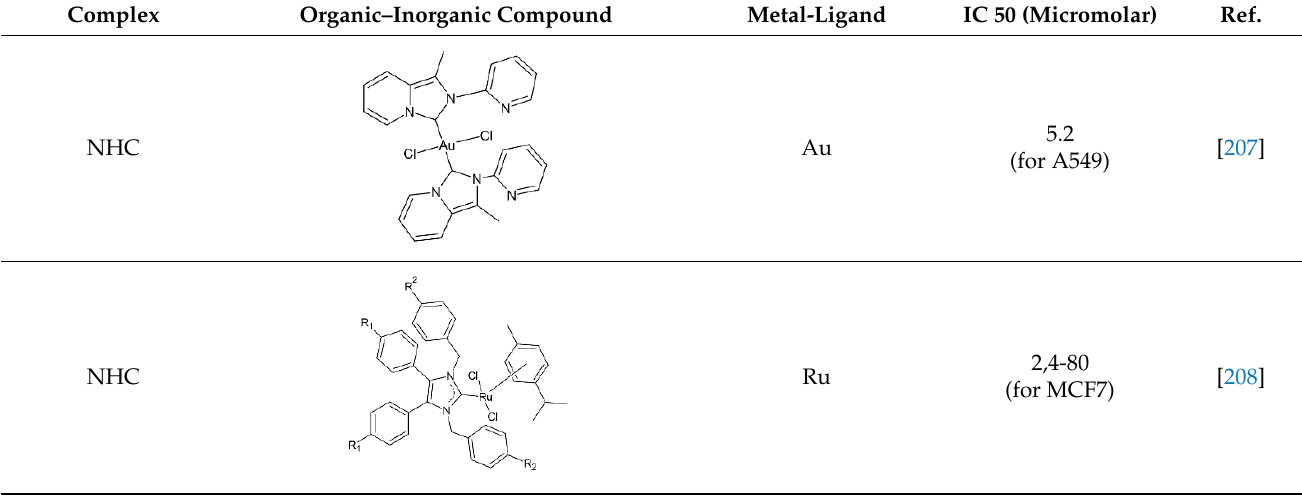
Table 4. Metal-centred complexes obtained and their anti-cancer activities. Complex